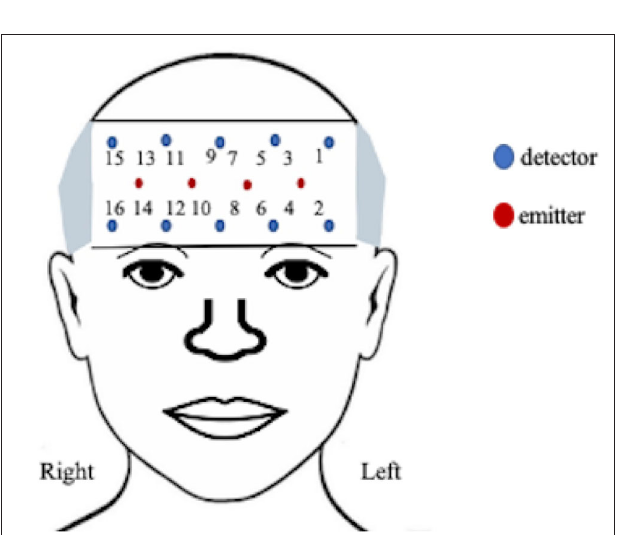
FIGURE 2 | Functional near-infrared configuration.